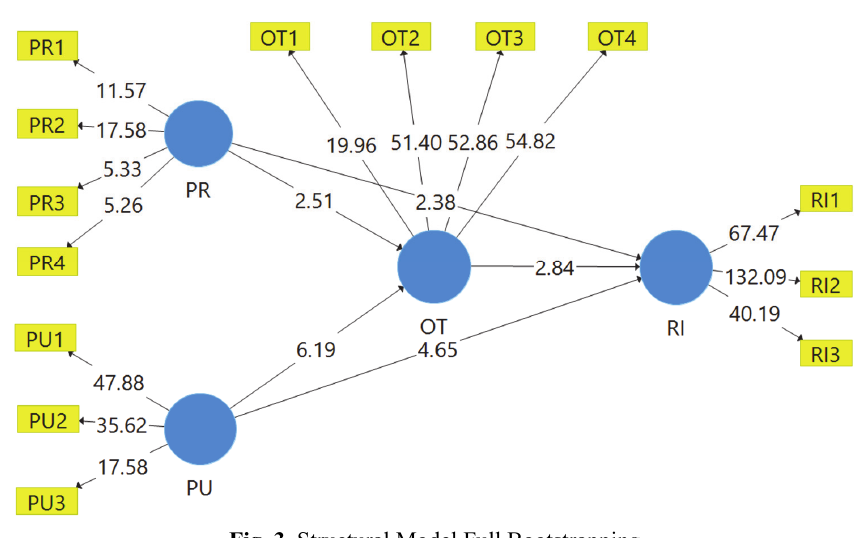
Fig. 3. Structural Model Full